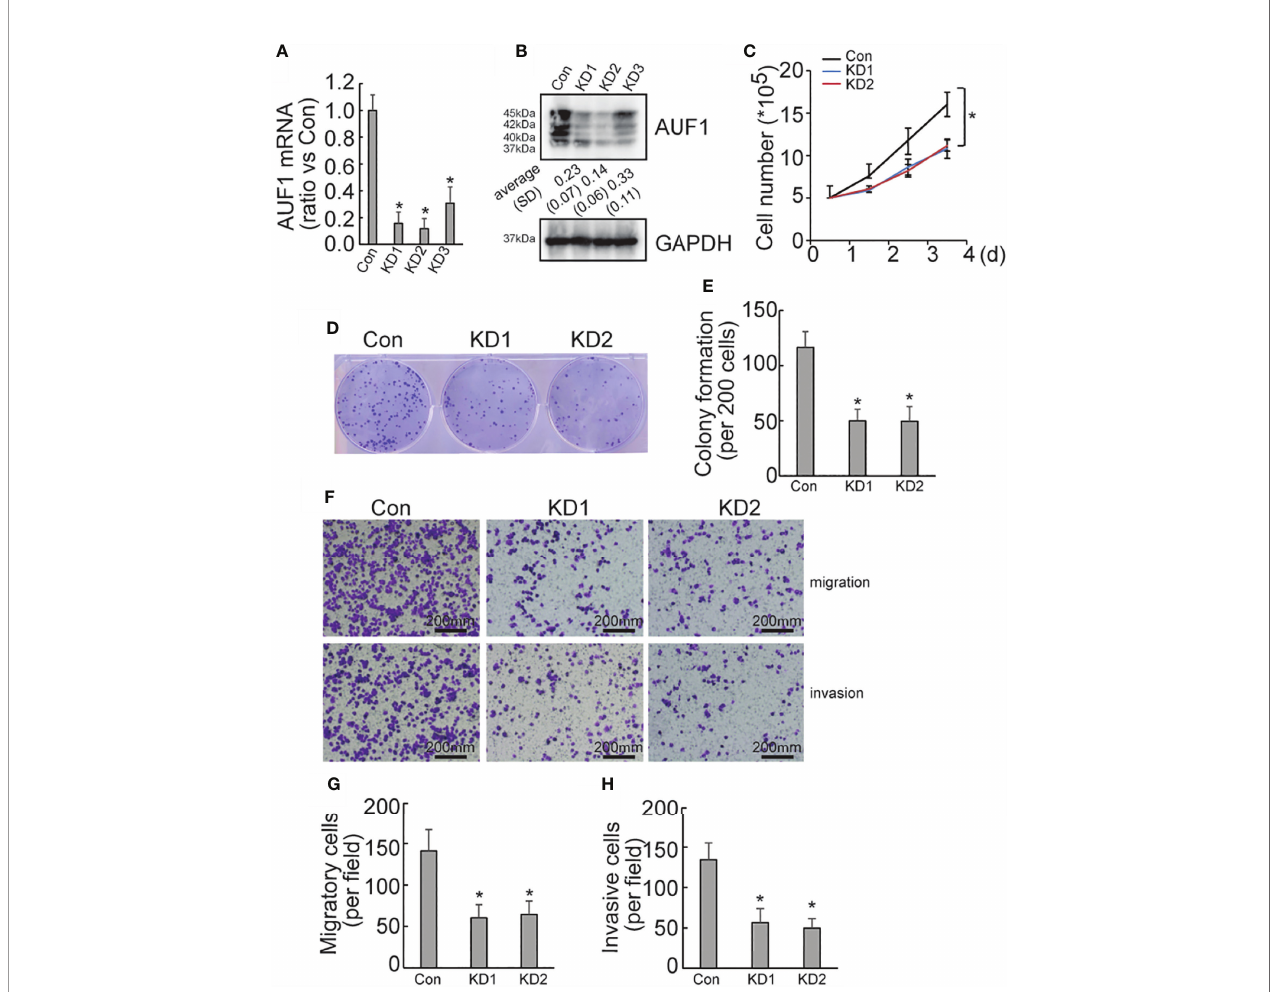
FIGURE 1 | Proliferation, migration, and invasion ability of Con and AUF1-knockdown IHH4 cells. (A) The CRISPR/Cas9 system was applied to knock down AUF1 in IHH4 cells, and Real time PCR was performed to clarify knockdown of AUF1 in thyroid cancer cells; (B) western blot was performed to verify the knockdown ef fi ciency; (C) to evaluate the proliferation ability of IHH4 cells, 1 × 10 5 cells were seeded and counted on day 1 – 4 in both the control group (Con) and AUF1- knockdown groups (KD1 and KD2), n = 3, * P < 0.05; (D) IHH4 cells in Con, KD1, and KD2 groups were seeded separately as single cells with 200 numbers per well in a six-well plate, and a representative photograph of colony formation was presented; (E) the IHH4 colonies were quantitively analyzed by using ImageJ software, n = 3, * P < 0.05; (F) Transwell assay containing Matrigel were applied to observe the migration and invasion ability of IHH4 cells in Con, KD1, and KD2 groups, respectively. The representative photographs under microscope (200 m m) were shown; (G) the numbers of migrated cells in Transwell assay were counted, n = 3, * P < 0.05; (H) the numbers of invading cells in Matrigel containing Transwell assay were counted, n = 3, * P <